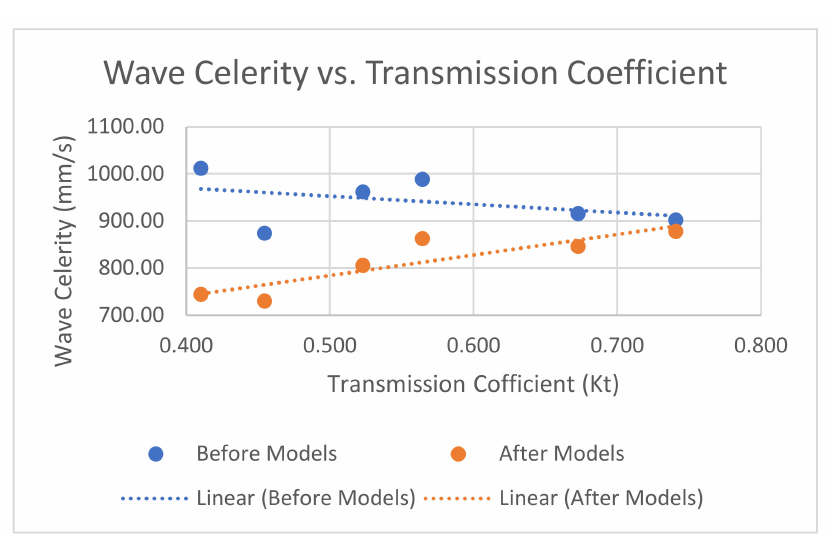
Figure 6. Variation of the wave celerity with the transmission coefficient.